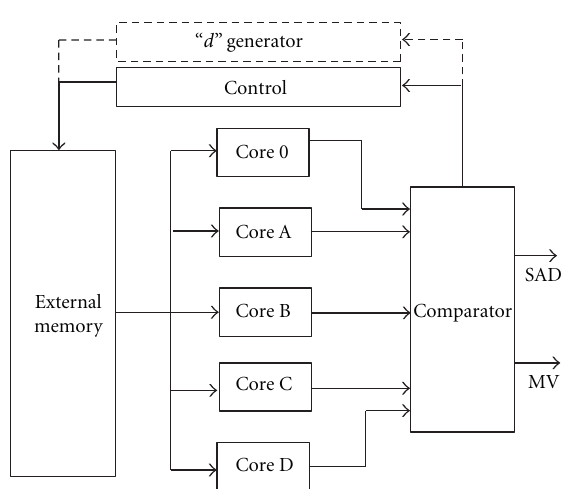
Figure 10: Block diagram of the DMPDS architecture.